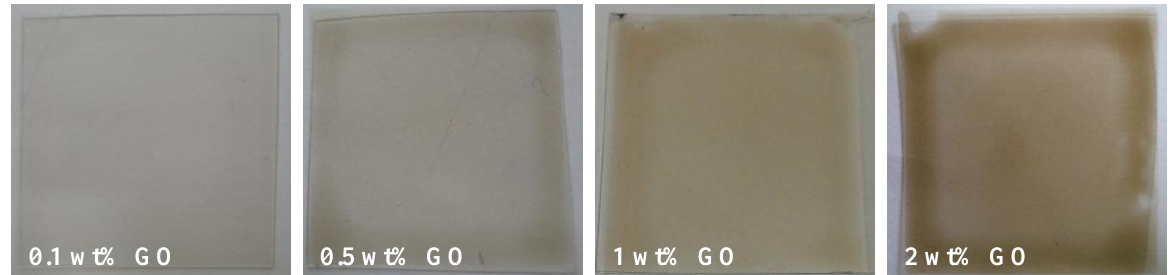
Figure 10. The GO-doped PVDF films with different GO concentrations. The PVDF concentration is 10 wt%.